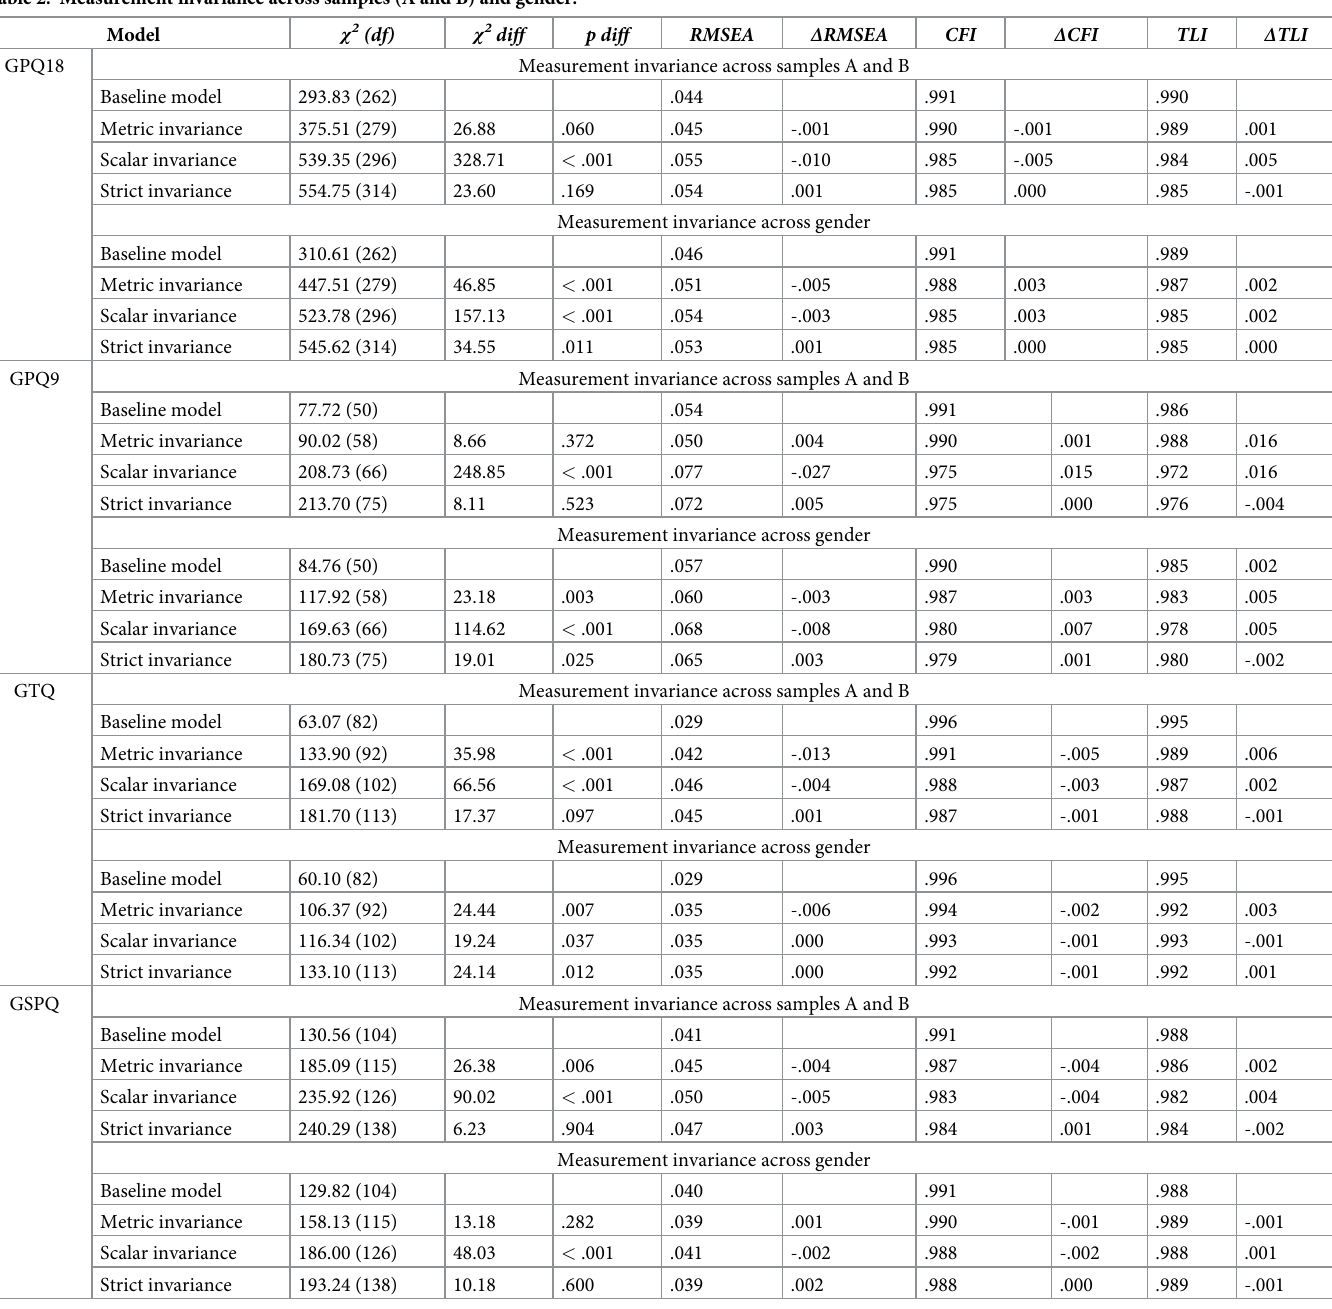
Table 2. Measurement invariance across samples (A and B) and gender.